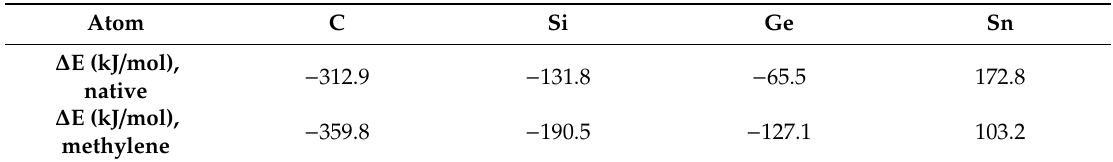
Table 2. Energy di ff erences ∆ E (kJ / mol) (calculated by DFT) between the crystal structures of compounds 9b and 9c with di ff erent group 14 elements (native), as well as analogous structures 9b’ and 9c’ in which oxygen atom 2 was replaced by methylene